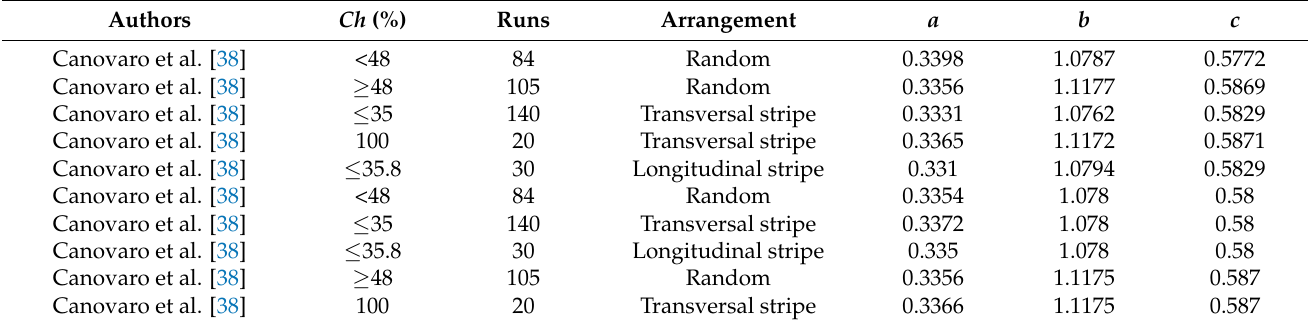
Table 2. Values of a , b , and c coefficients obtained for the different